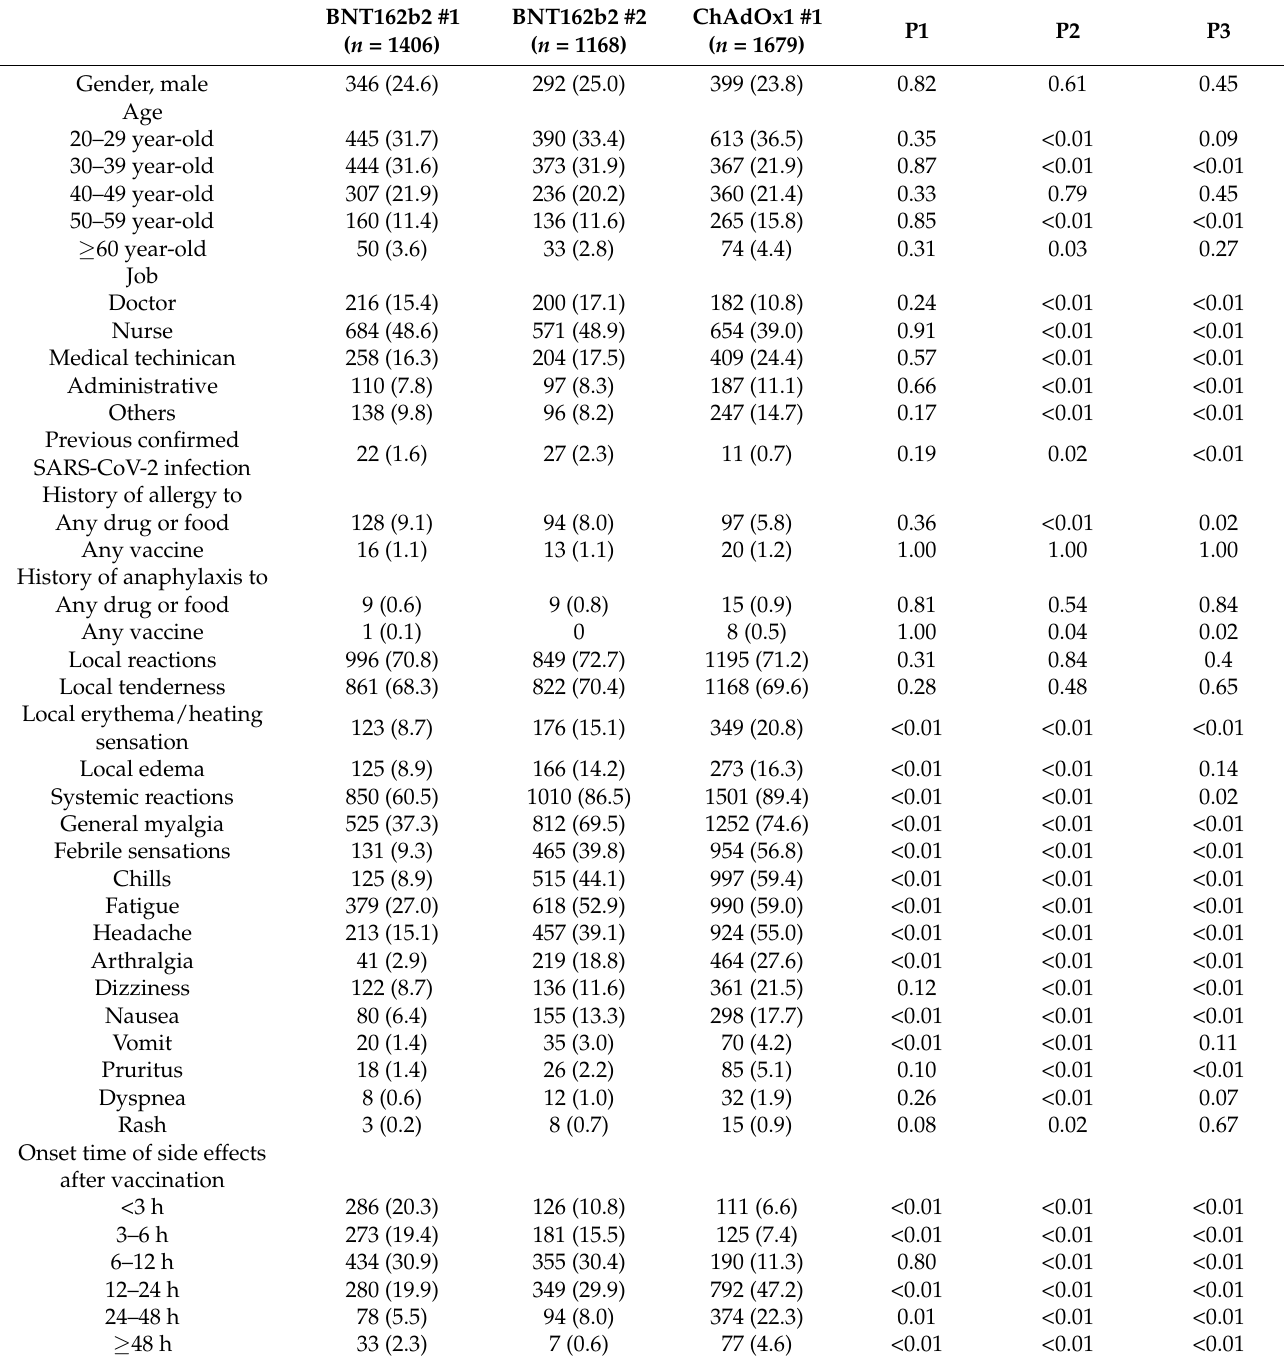
Table 1. Side effects and their impact on work productivity and need for medical attention after BNT162b2 and ChAdOx1 anti-SARS-CoV-2